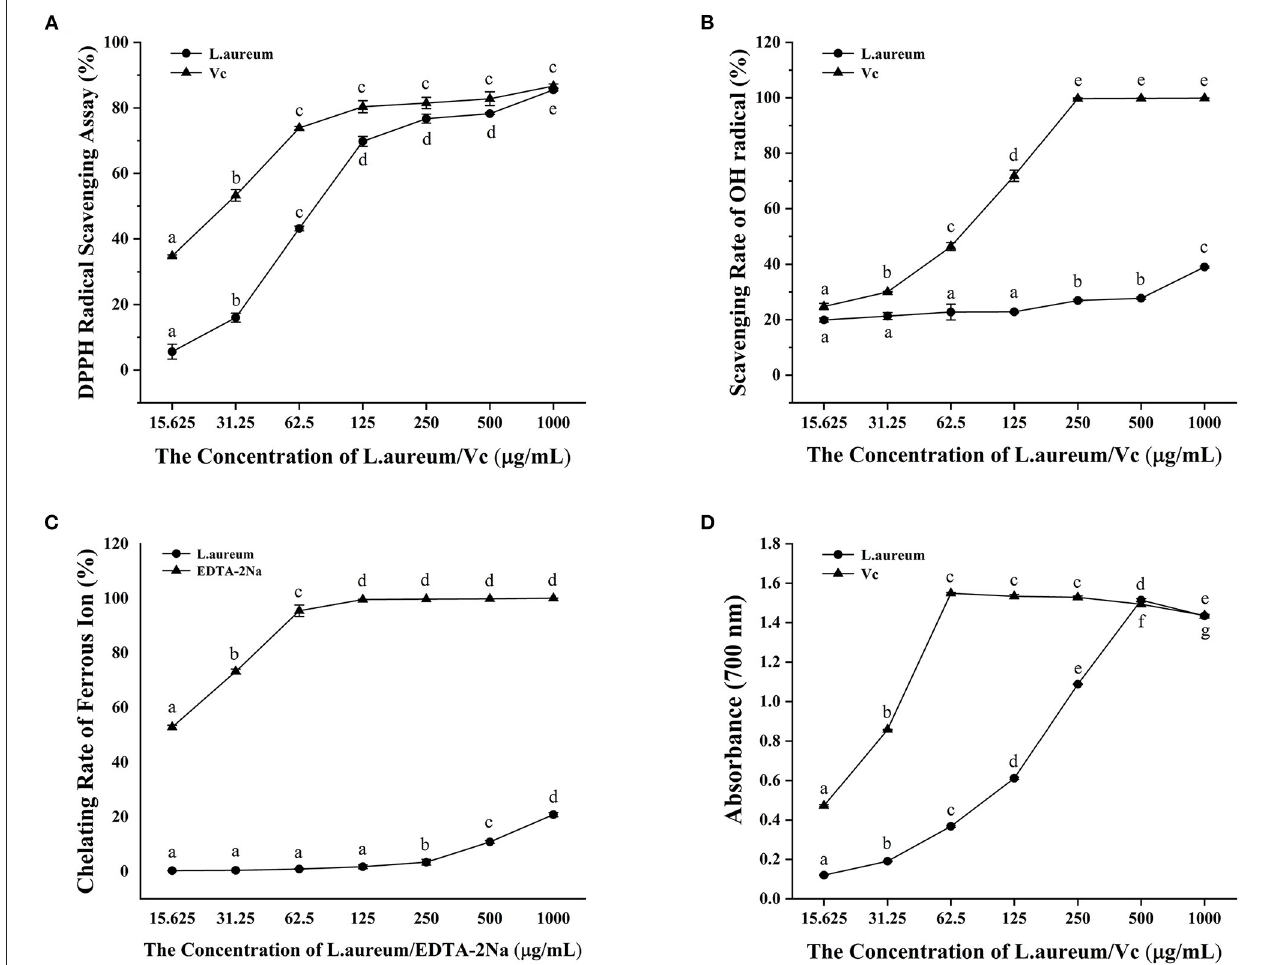
FIGURE 2 | In vitro antioxidant activity of L. aureum . (A) Scavenging activity against the DPPH radical. (B) Scavenging activity against the OH radical. (C) Ferrous ion-chelating ability. (D) Ferric reducing power. The significant difference ( p < 0.05) in the same sample is indicated by different